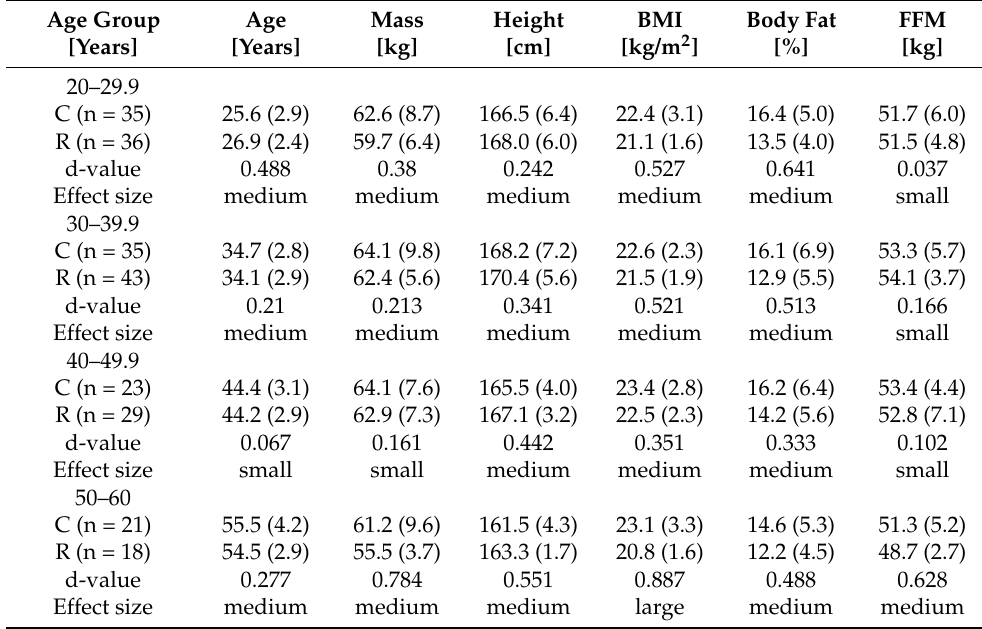
Table 3. Physical characteristics and body composition in female recreational cyclists (C) and run- ners (R).